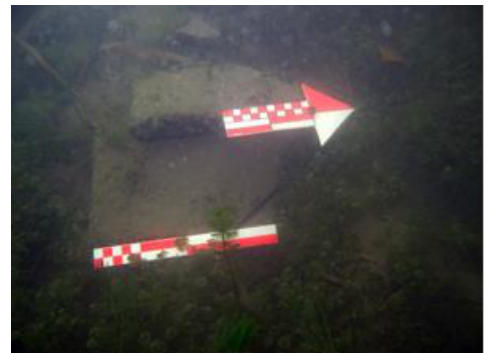
Figure 11. Gambulaga – Portomaggiore (FE), Tramonto Lake, Roman